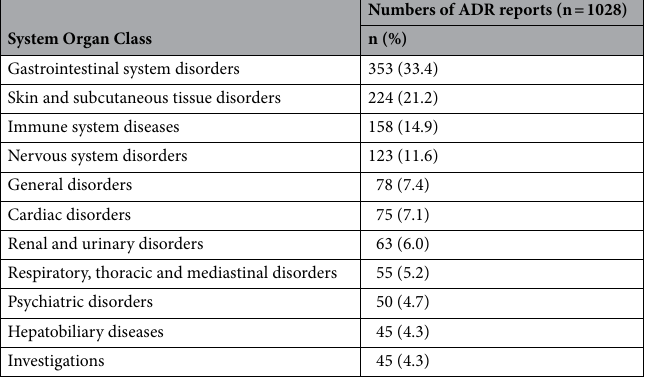
Table 4. Numbers of adverse events in the TADRRS-HM (1998–2016), grouped by System Organ Class. TADRRS-HM Taiwan Adverse Drug Reaction Reporting System for Herbal Medicine.